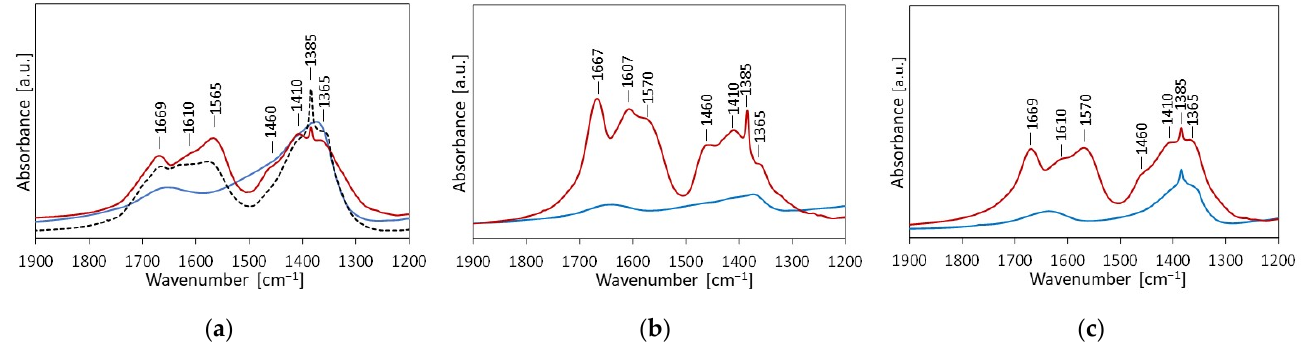
Figure 10. FTIR spectra of fresh (blue line) and spent (red line) HT catalysts: ( a ) HT–CO 3 /s; ( b ) HT–Cl/s; ( c ) HT–Br/s. Dashed line—spectrum of HT–CO 3 /s after reaction in acetonitrile/H 2 O 2 solution.